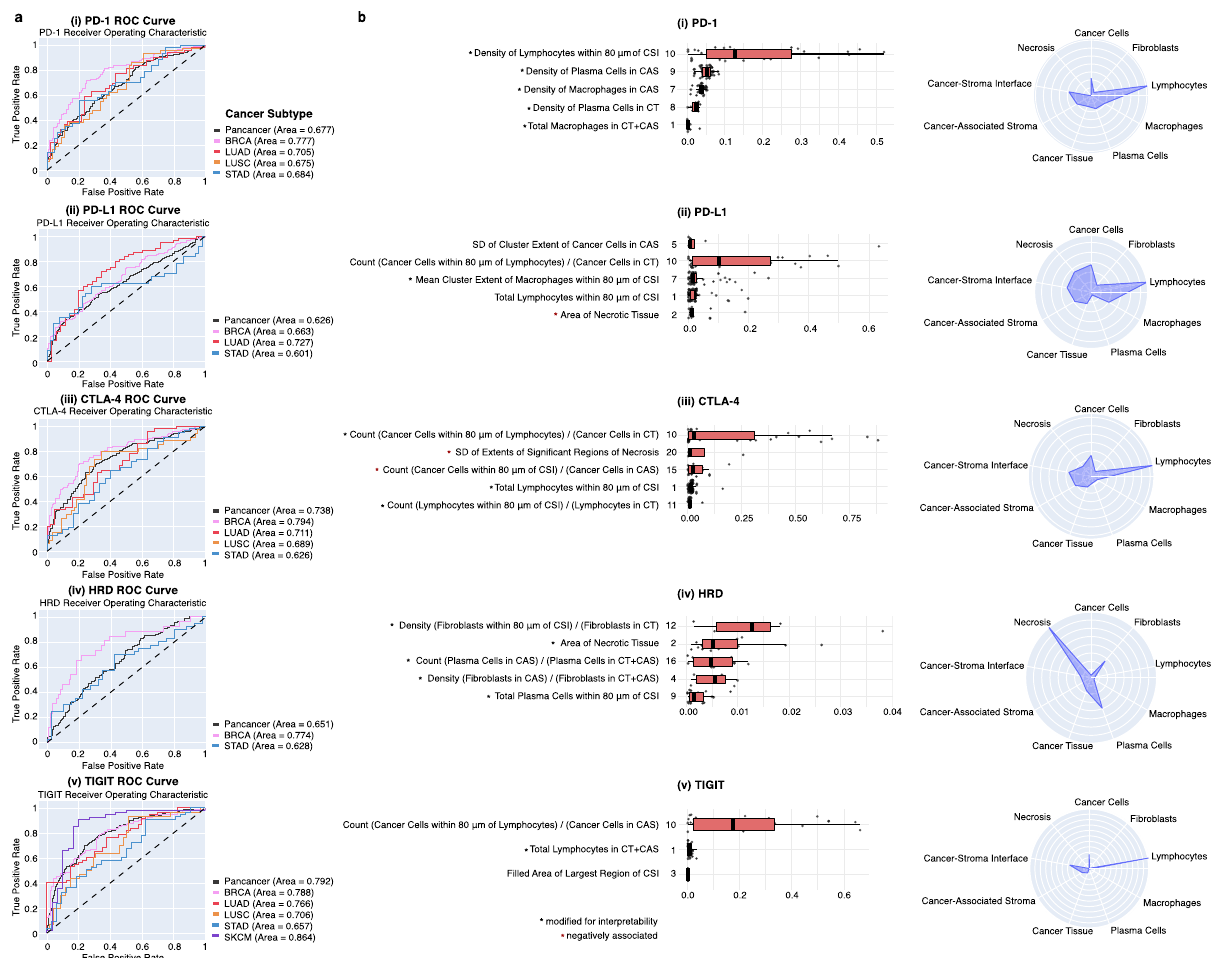
Fig. 6 HIF-based prediction of molecular phenotypes. a Receiver operator characteristic (ROC) curves for (i) PD-1, (ii) PD-L1, (iii) CTLA-4, (iv) HRD, and (v) TIGIT hold-out predictions across cancer types and pan-cancer. Skin cutaneous melanoma (SKCM) predictions were conducted only for TIGIT due to low sample sizes. Pan-cancer predictions use binary labels thresholded independently by cancer type. For TIGIT predictions, pan-cancer includes all fi ve cancer types. For the remainder of predictions, pan-cancer includes all cancer types excluding SKCM. Random classi fi ers correspond to area under the ROC curve (AUROC) = 0.50. b Visualization of predictive human-interpretable image features (HIFs) for each molecular phenotype. Boxplots show the top fi ve most predictive HIF clusters for each phenotype in pan-cancer models. For TIGIT predictions, pan-cancer models only included three non-zero HIF clusters. Clusters are ranked by the maximum absolute ensemble beta across HIFs in a given cluster. Ensemble betas are computed per HIF as the average across the three models incorporated into the fi nal ensemble evaluated on the hold-out set. The center and bounds of each boxplot represent the median and interquartile range (IQR; 25th, 75th percentiles) for HIF betas in each cluster, respectively. Upper and lower boxplot whiskers represent the smaller of the maximum beta value or the 75th percentile + 1.5 × IQR and the larger of the minimum beta value or the 25th percentile − 1.5 × IQR, respectively. Each cluster is labeled with a representative HIF corresponding to the maximum absolute ensemble beta value. The number of ensemble betas (HIFs) used to derive each boxplot is: 32, 49, 32, 9, and 11 (from top to bottom) for PD-1 clusters; 8, 30, 49, 20, and 70 for PD-L1 clusters; 38, 4, 14, 77, and 20 for CTLA-4 clusters; 7, 15, 11, 8, and 19 for HRD clusters; and 26, 22, and 2 for TIGIT clusters (see Supplementary Data 1 for the number of HIFs per cluster). In cases where that HIF is dif fi cult to interpret, a more interpretable HIF within a fi vefold difference of the maximum ensemble beta is presented (indicated by a black asterisk). As absolute values were used for ranking, HIFs with negative ensemble betas are denoted by a red asterisk. Boxplots of predictive HIF clusters for cancer type-speci fi c models are included in Supplementary Fig. 11. Radar charts show the normalized magnitude of ensemble betas in pan- cancer models strati fi ed across nine HIF axes, corresponding to the fi ve cell types, three tissue types, and cancer – stroma interface (CSI). Normalized magnitudes were computed as the sum of absolute ensemble betas for HIFs associated with each axis divided by the total number of HIFs associated with the said axis (e.g., all HIFs involving fi broblasts). Multiple predictive HIFs are visualized with overlaid cell- or tissue-type heatmaps in Fig. 3. Tumor regions include cancer tissue (CT), cancer-associated stroma (CAS), and a combined CT +